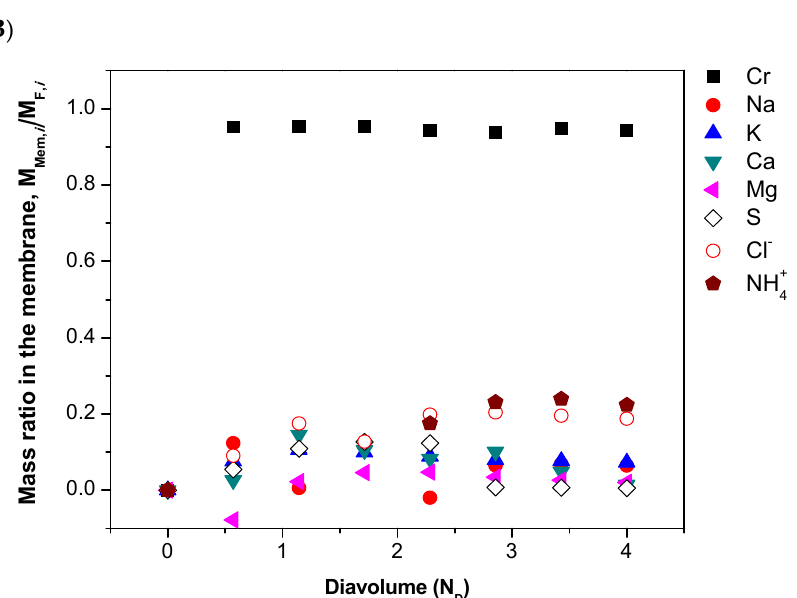
Figure 9. ( A ) Mass ratio of each compound i permeated and ( B ) mass ratio of each compound i retained in the cs-PES MF022 membrane during diafiltration at 20 bar. Mass ratio for each compound was calculated in reference to the total mass of the same compound, M F,I , in the SW30 concentrate of a real tannery effluent before diafiltration (diafiltration feed solution).